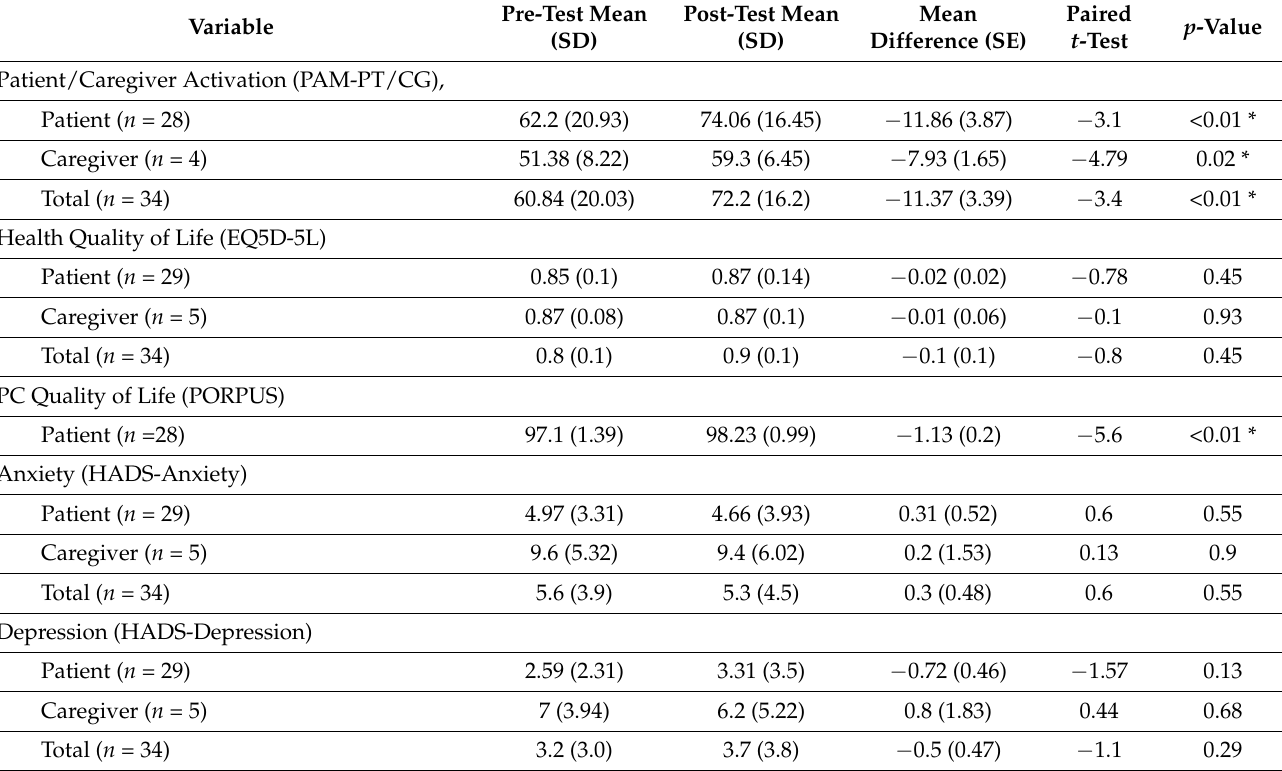
Table 5. Pre/post-intervention assessment of possible